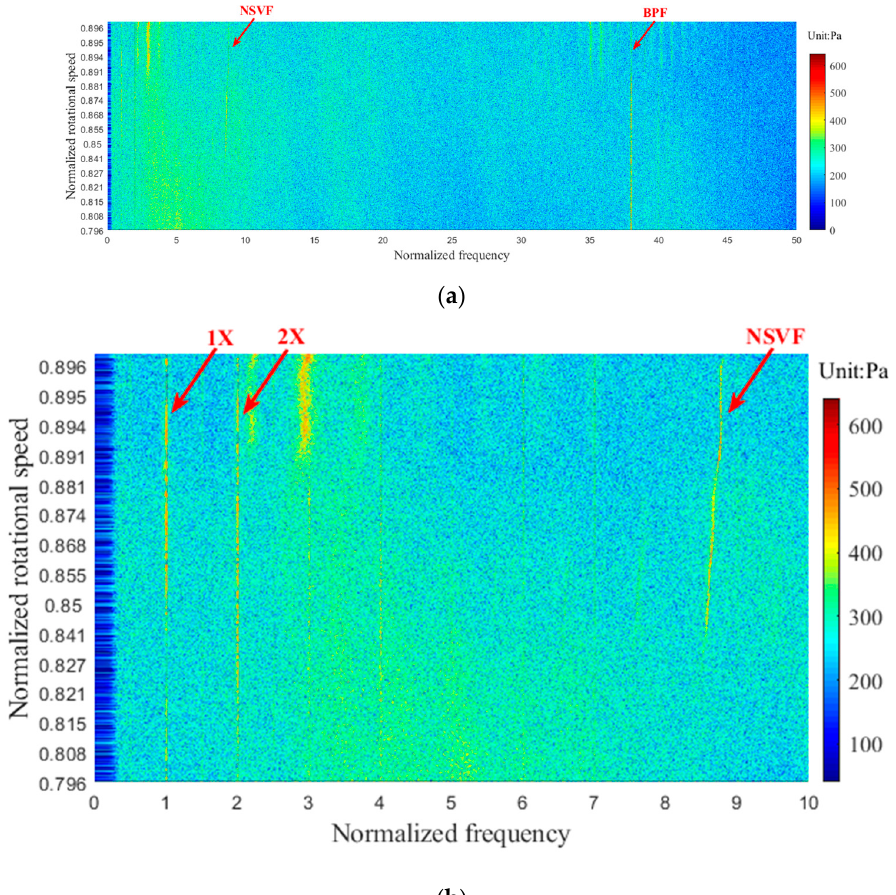
Figure 18. Waterfall plot of the NSV state (PVDF-01): ( a ) normalized frequency range 0–50, ( b ) normalized frequency range 0–10.